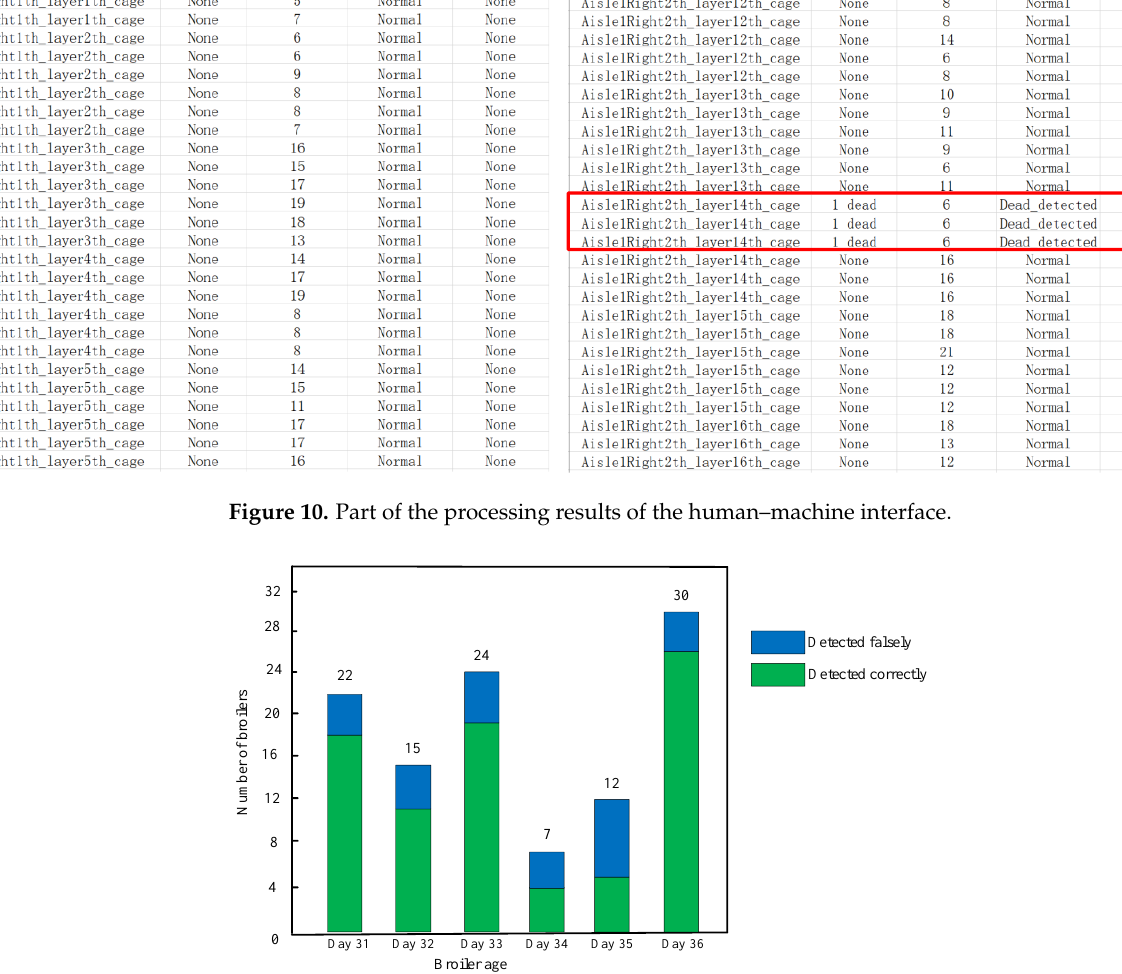
Figure 11. Detection results of dead broilers in days 31 – 36.